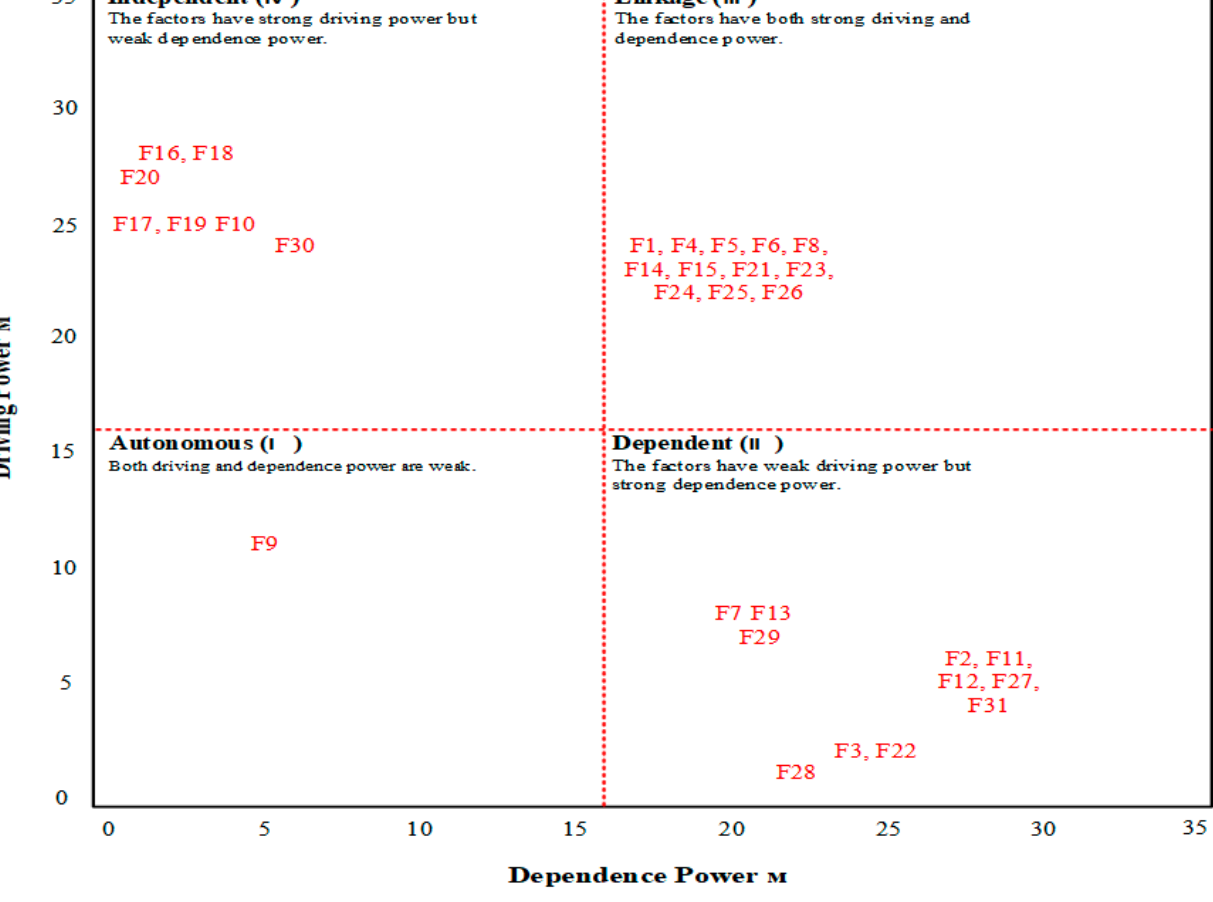
Figure 5. MICMAC analysis for enablers. Note. See Table 2 for enablers names.